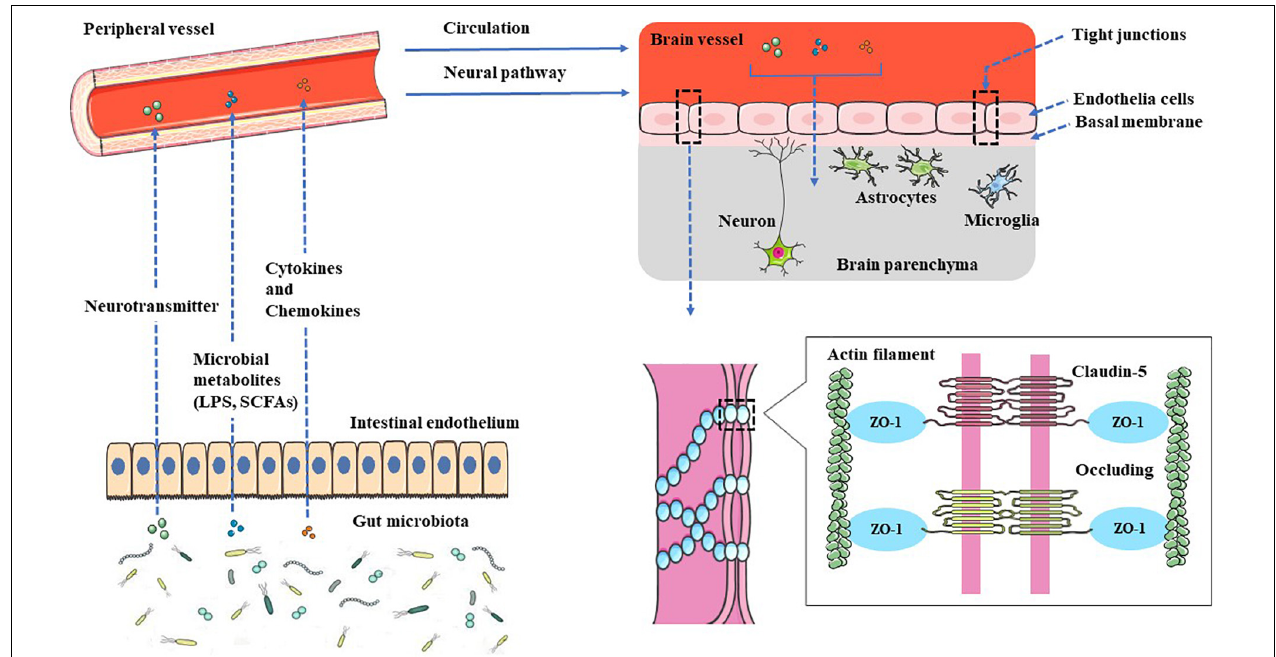
FIGURE 1 | Gut–brain communication. Gut microbial surface substances and their metabolites can positively or negatively affect the CNS through the peripheral circulation or enteric nervous system, and microbial-derived neurotransmitters have regulatory effects on neurons or nerve cells after entering the brain. The metabolites can not only play an anti-inflammatory effect, protect the BBB but also play a pro-inflammatory effect, activate microglia to secrete inflammatory mediators, and then damage the BBB, leading to